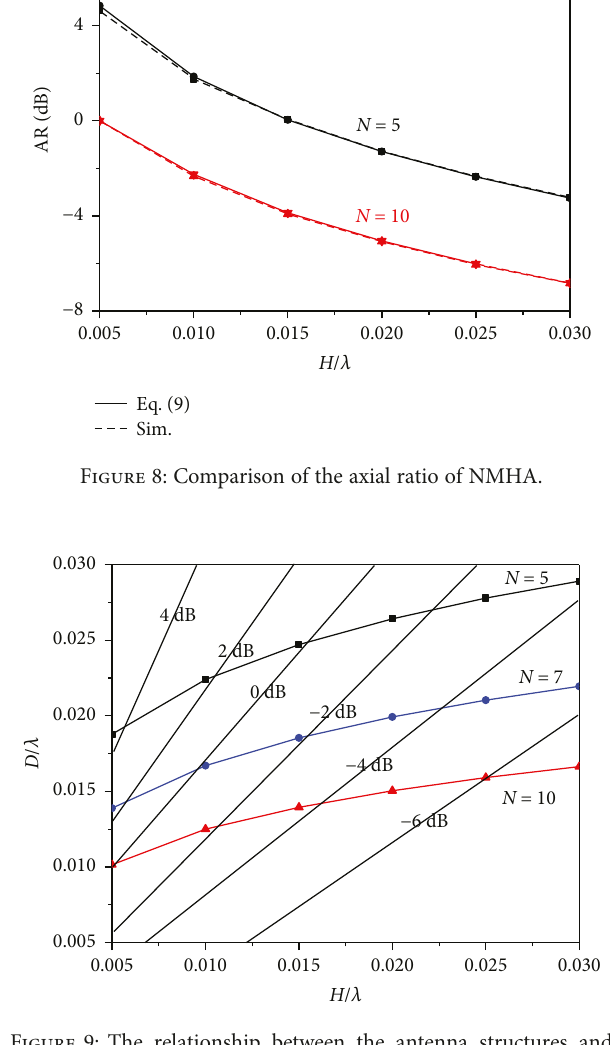
Figure 9: The relationship between the antenna structures and axial